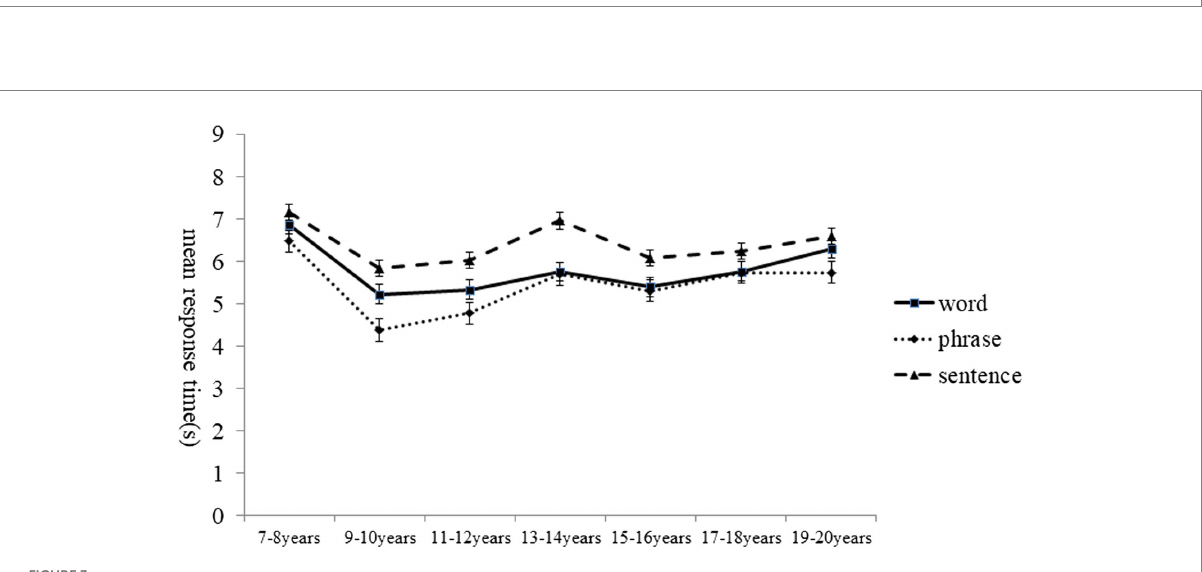
FIGURE 3 Mean response time of speechreading in Chinese as a function of age group and linguistic